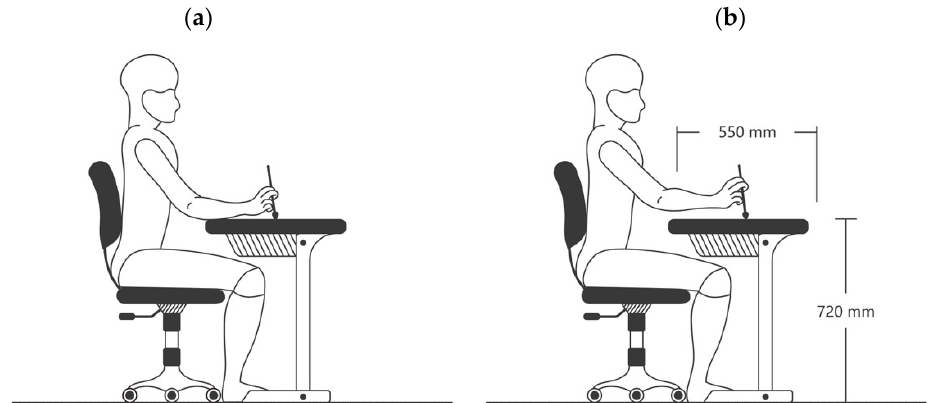
Figure 4. The experimental setting with a demonstration of the ( a ) suspended wrist and ( b ) raised wrist position. wrist